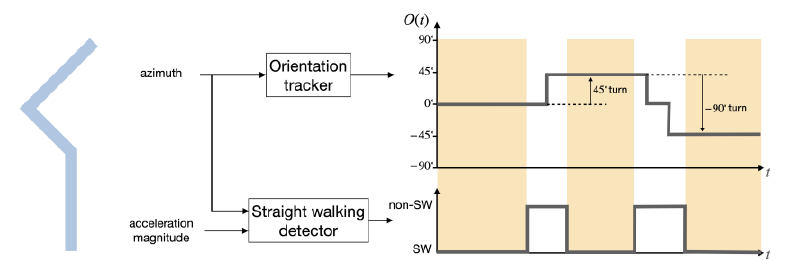
Figure 2. Diagrammatic example of our two-stage turn detector. The blue line ( left ) represents a path taken by a walker, with a 45° ( left ) turn, followed by a − 90° ( right ) turn. A turn is detected by comparing the orientation 𝑂(𝑡) produced by the orientation tracker between two consecutive straight walking (SW) segments (highlighted in yellow).